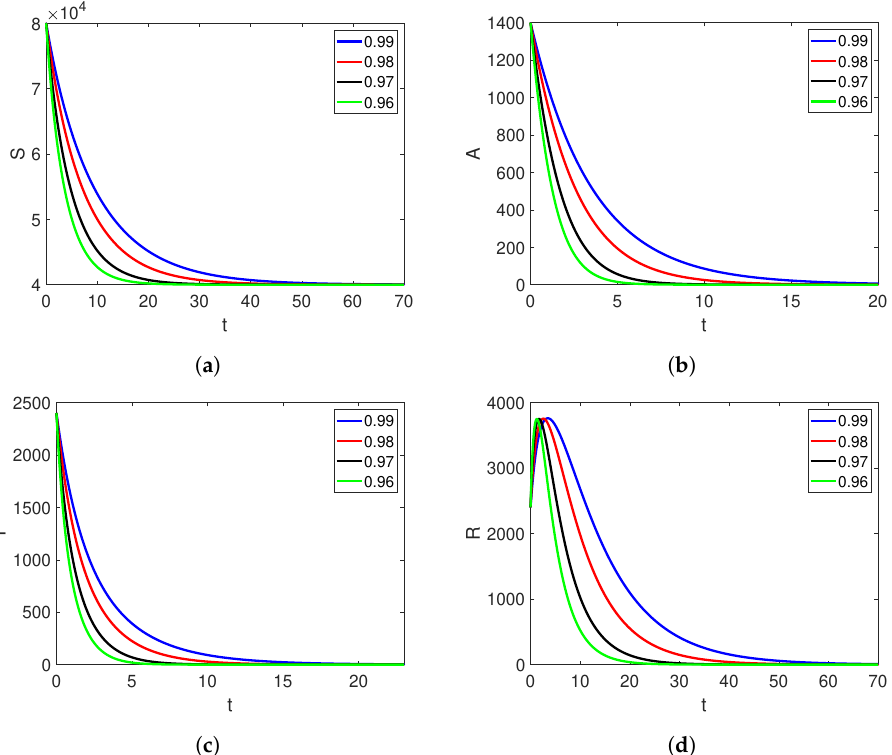
Figure 4. The dynamics of the state variables’ SAIR in model (2) with different fractional orders α vs. time t with initial conditions.